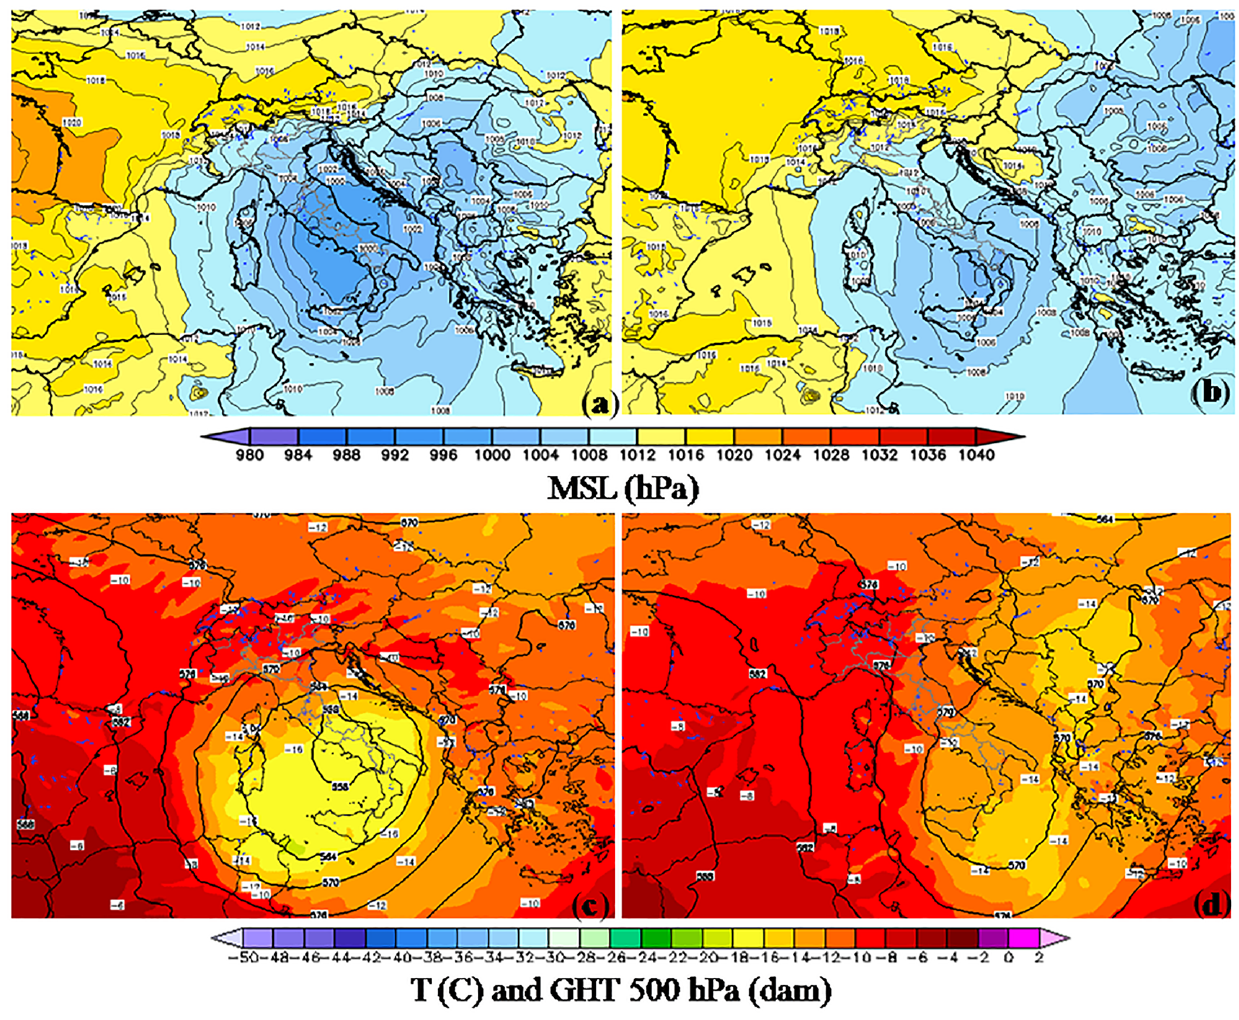
Figure 1. ECMWF (European Centre for Medium-Range Weather Forecasts) analyses at 12:00UTC on 14 September 2012: (a) mean sea level pressure and (c) temperature (colour shades) and geopotential height (black isolines) at 500hPa; ECMWF analyses at 12:00UTC on 15 September 2012: (b) mean sea level pressure and (d) temperature (colour shades) and geopotential height (black isolines) at